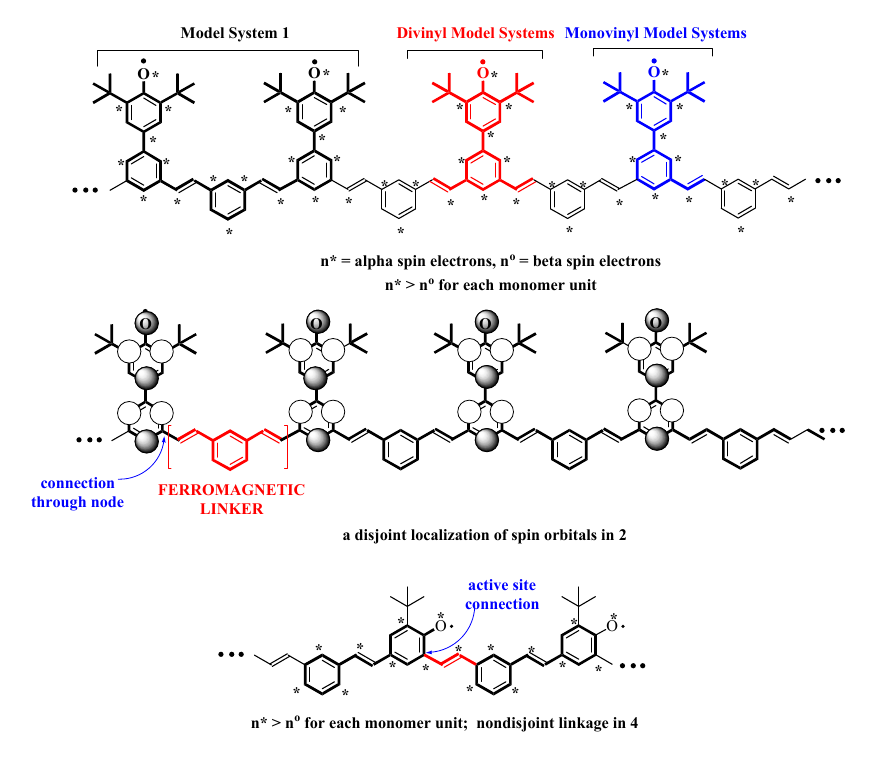
Figure 1. Parity based analysis for polymers 2 and 4 . Upper two structures show polymer 2 , parsed into segments by comparison model system 1 and model systems in Table 1 below. Lower structure shows polymer 4 parsed into stilbenic units related to 5